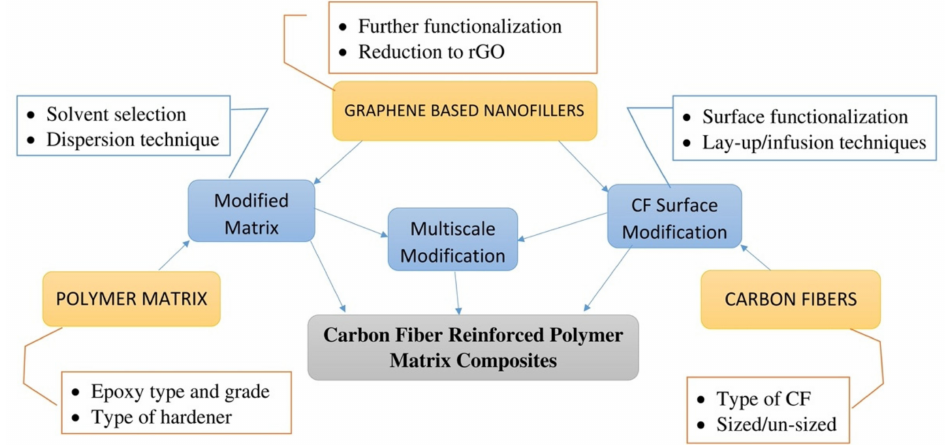
Figure 3. Flowchart for manufacturing GO-functionalized